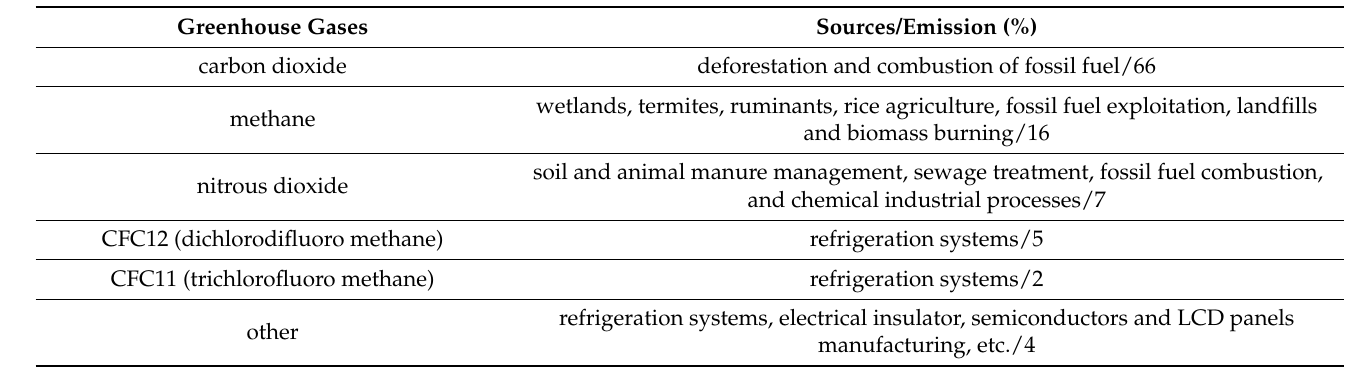
Table 1. Contributions of the most important long-lived greenhouse gases to the increase in global radiative force from the pre-industrial era to 2019 [3].